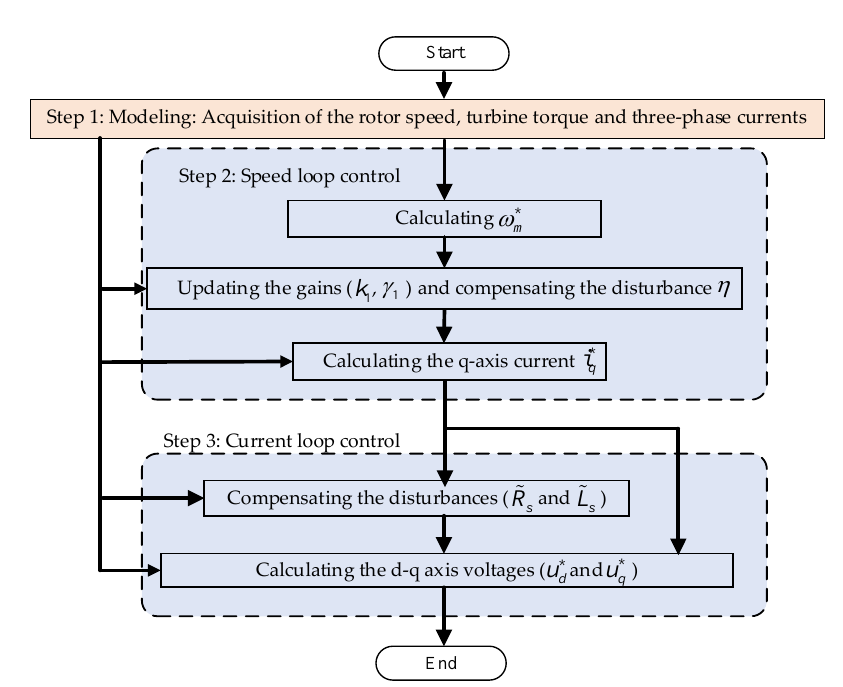
Figure 3. Detailed flowchart of the proposed fuzzy adaptive backstepping control (F-A-BC) method.